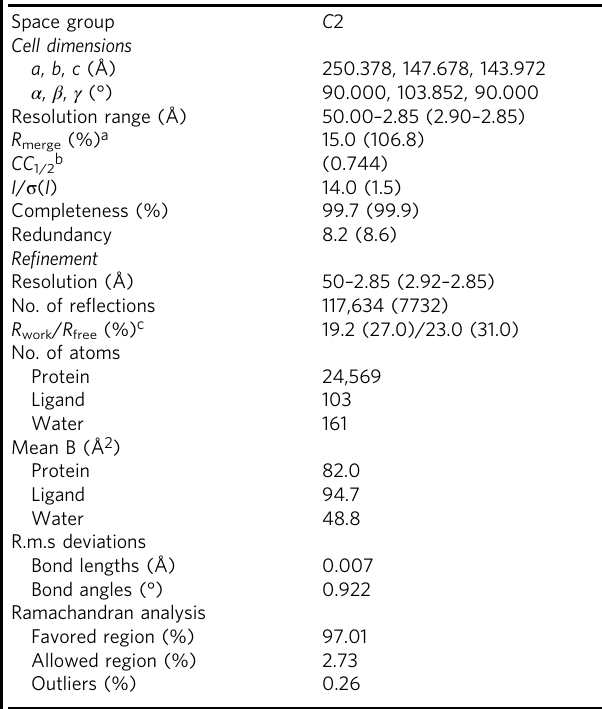
Table 2 Data collection and re fi nement